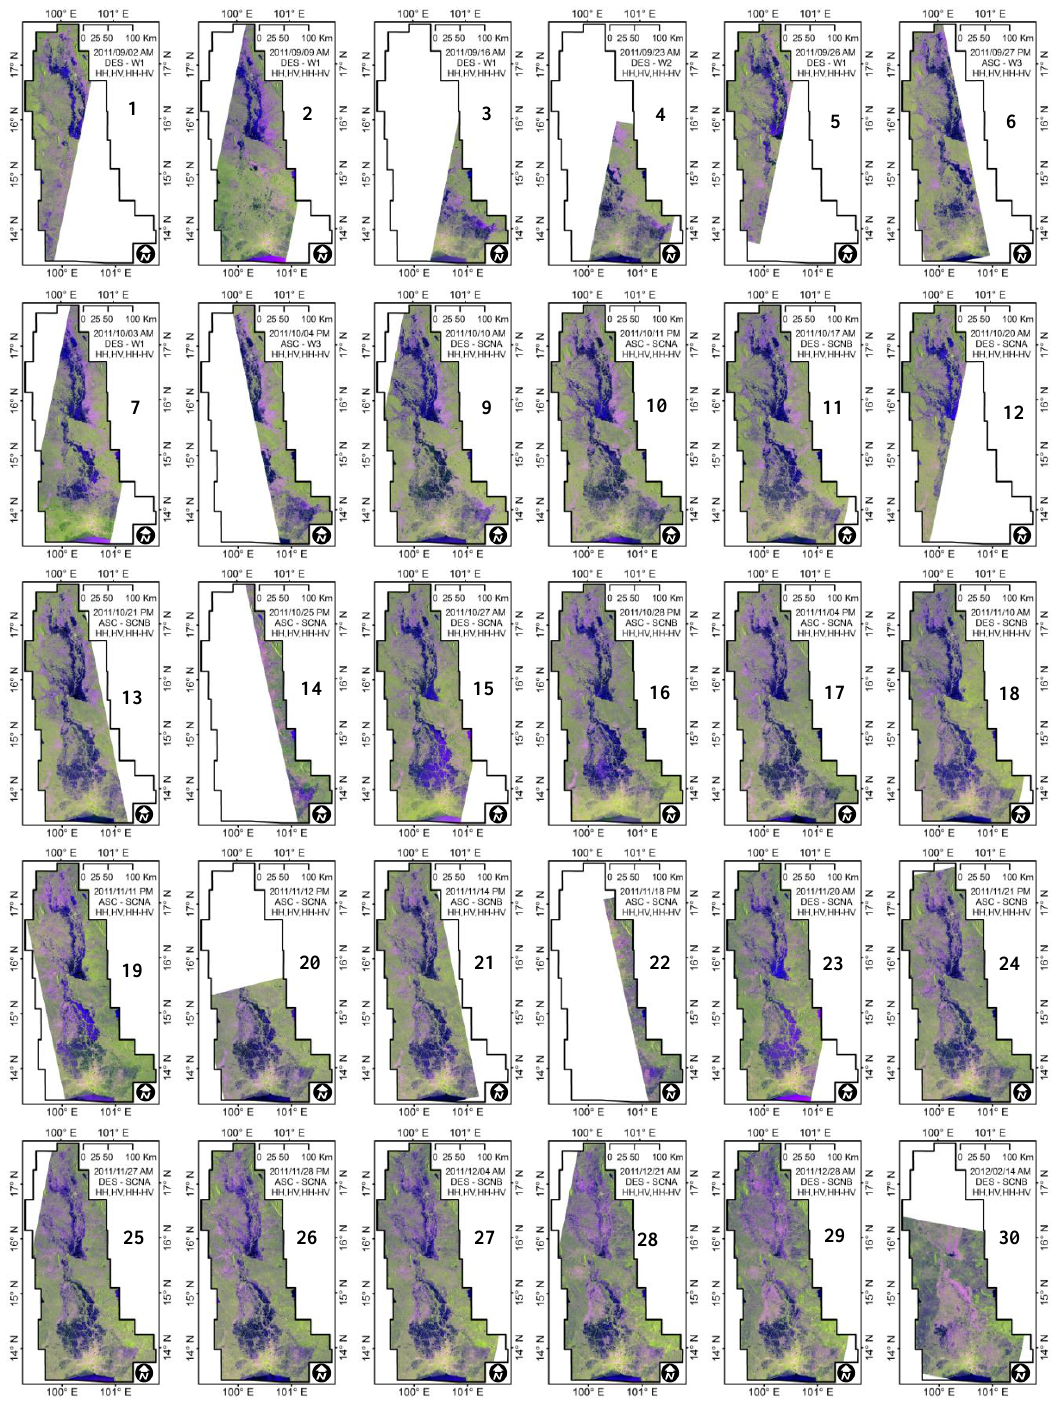
Figure 2. RADARSAT-2 color composite (HH as red, HV as green, and HH/HV as blue) images taken during the 2011 Thai flood event from the beginning to end.